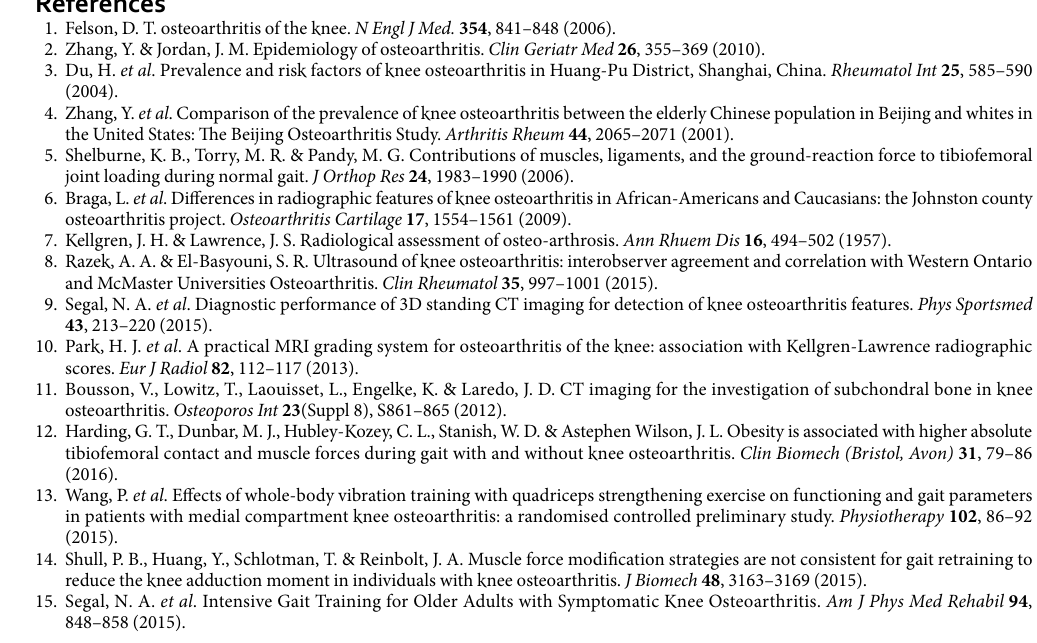
7 Scientific RepoRts | 7: 4080 | DOI:10.1038/s41598-017-04390-5